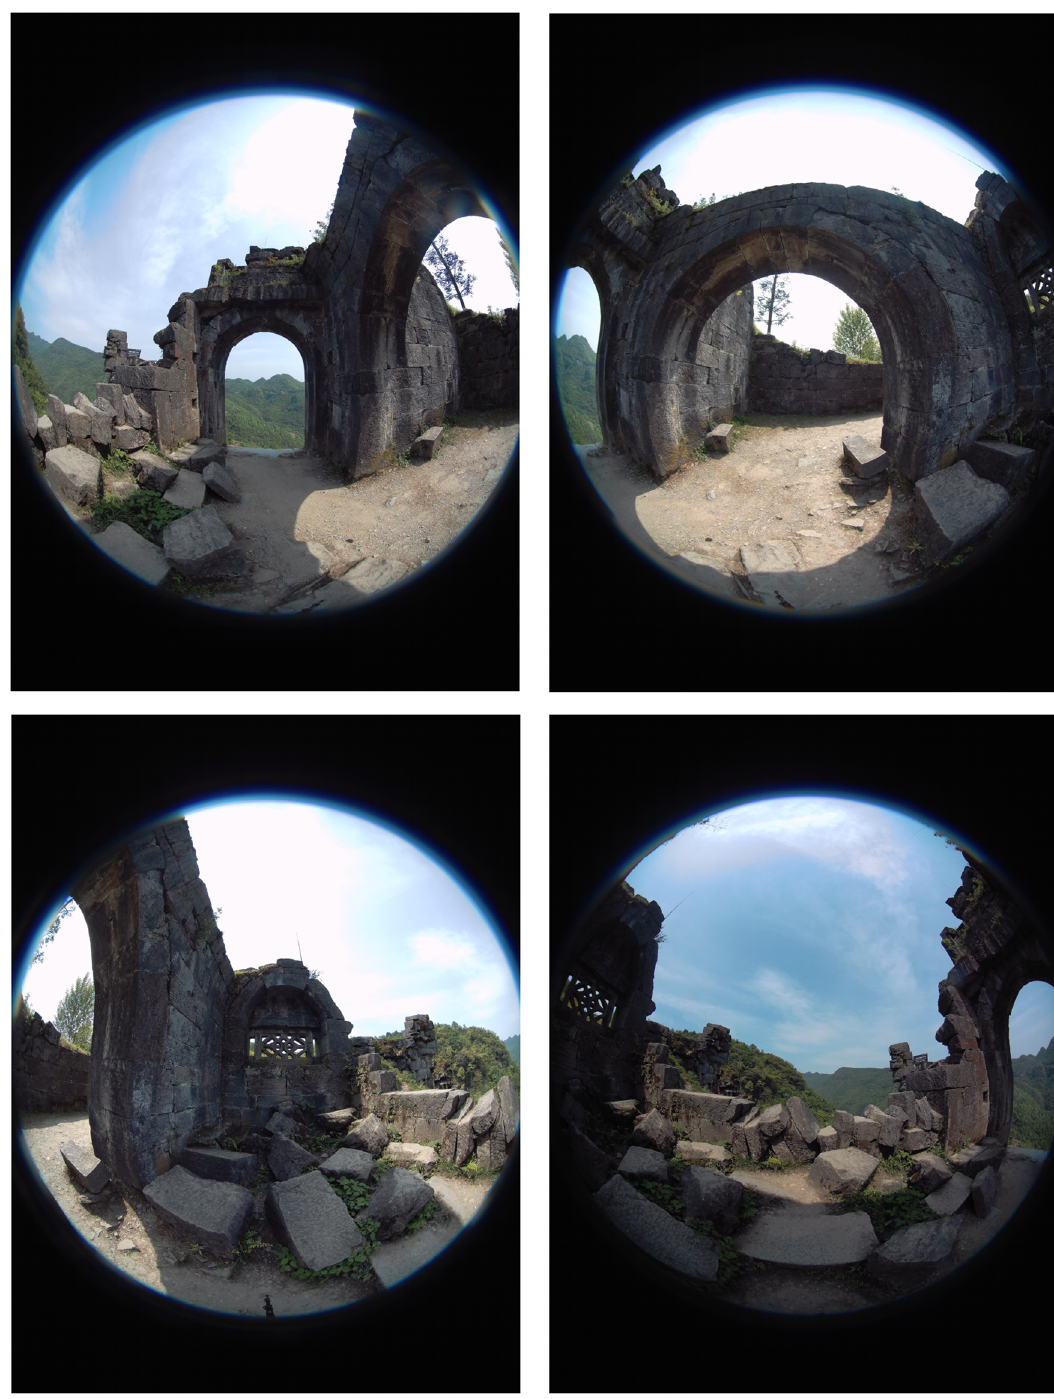
Figure 1: Presentation selected for Feilong